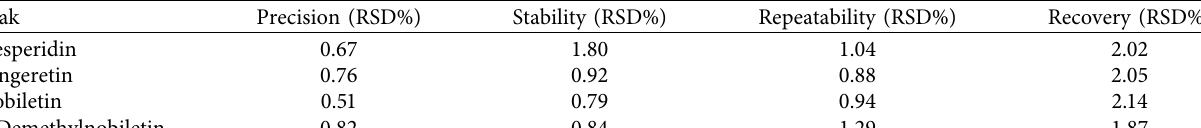
Table 3: Te precision, stability, repeatability, and recovery of four references.